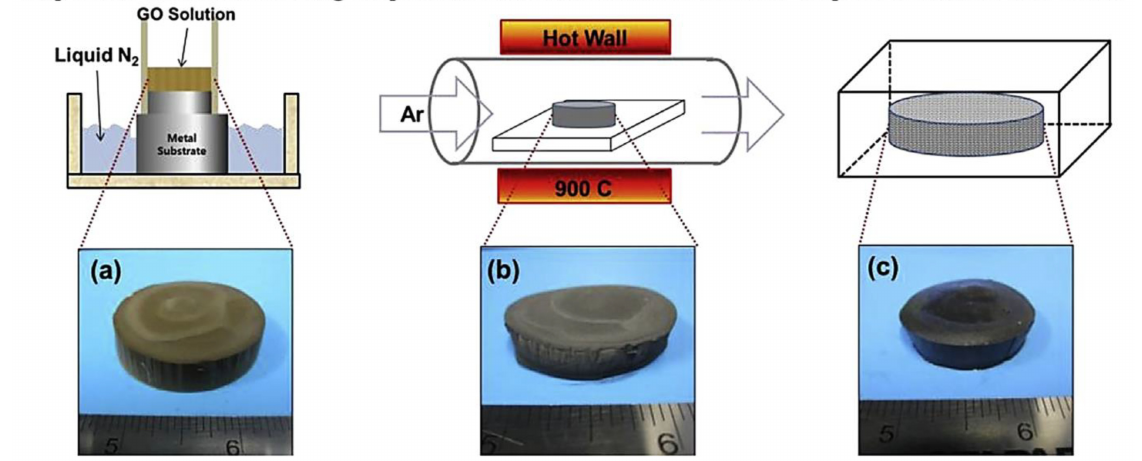
Figure 8. Schematic illustrating manufacturing procedure for ( a ) reduced graphene oxide nanofoam; ( b ) poly(dimethyl siloxane)/graphene nanofoam nanocomposite ( c ), and sliced slab of poly(dimethyl siloxane)/graphene nanofoam on probe fixture PDMS = poly(dimethyl siloxane); LFG = large flake graphite; SFG = small flake graphite. Reprinted with permission from Ref. [87]. 2015, Elsevier.